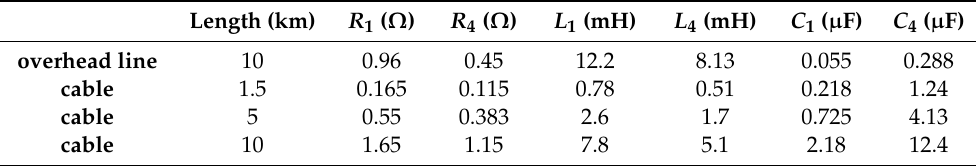
Table 4. Typical values of the elements in module of the distribution line module.